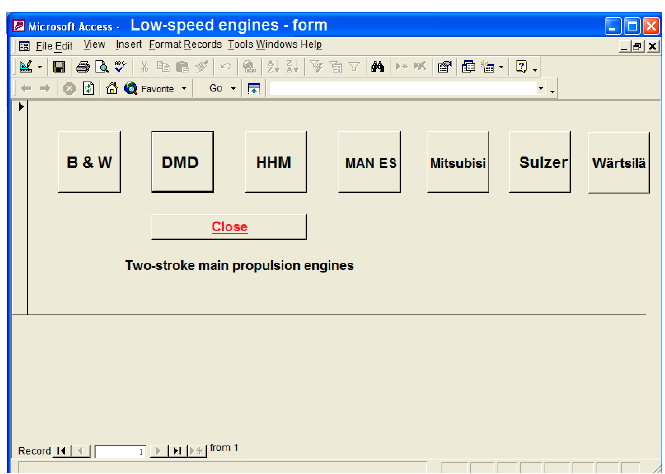
Figure 3. View form of producers the main engine: B & W—Burmeister & Wain, DMD—Dalian Marine Diesel Engine Co., Ltd. HHM—Hudong Heavy Machinery Co., Ltd., MAN ES—MAN Energy Solution.